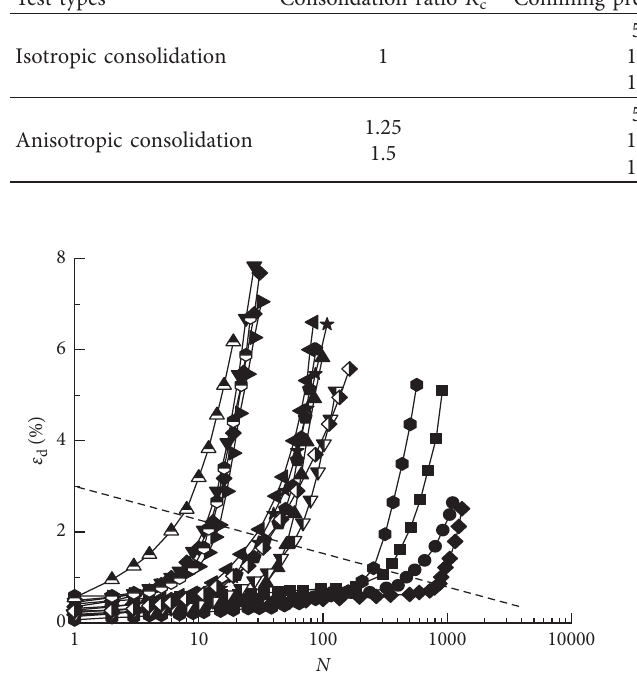
Figure 5: Relationship curves between ε confining pressures.